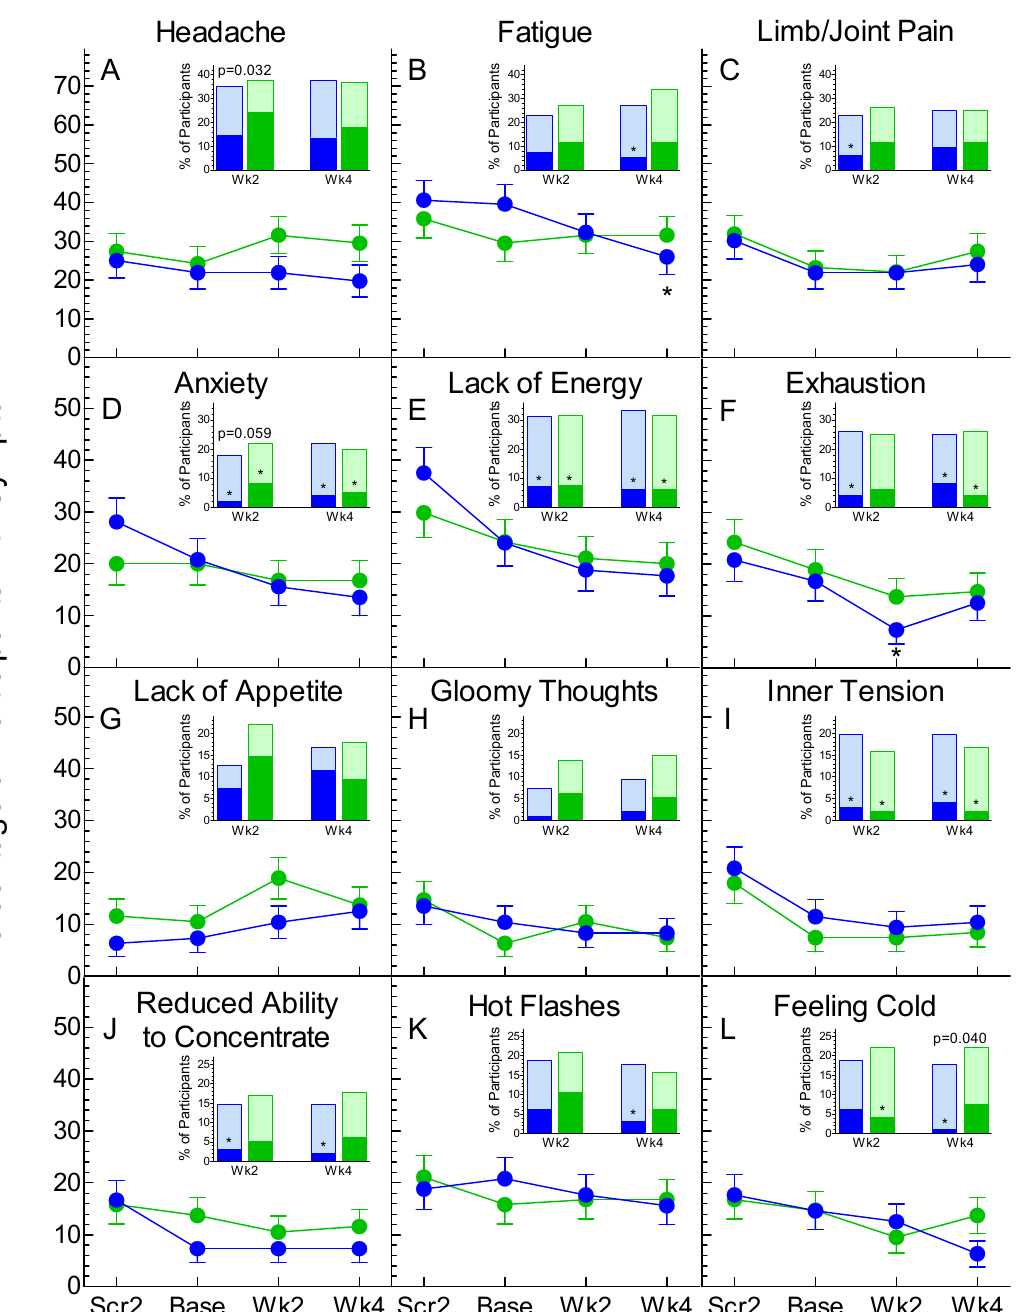
Figure 2. Prevalence and severity of headache ( A ), fatigue ( B ), limb/joint pain ( C ), anxiety ( D ), lack of energy ( E ), exhaustion ( F ), lack of appetite ( G ), gloomy thoughts ( H ), inner tension ( I ), reduced ability to concentrate ( J ), hot flashes ( K ) and feeling cold ( L ). Main panels: Values are means ± SD for n = 96 on Test (blue symbols and bars) and n = 95 on Control (green symbols and bars). Scr2 = second screening visit; Base = baseline; Week2 = week 2, Wk4 = week 4. * Prevalence significantly different from that at the Baseline visit by chi-squared test ( p < 0.05). Insets: Percentage of participants in whom the symptom was more severe (dark bars) or less severe (light bars) than the severity before treatment (median severity at Scr2 and Base). The percent of participants with no change in severity is not shown. p -values are the significance of the difference between the ratio of M:L on Test vs. Control ( p < 0.05 by Fisher’s exact test). * Ratio of M:L significantly different from 1:1 ( p < 0.05 by binomial distribution) where M and L are the number of participants in whom the symptom was more severe (M) or less severe